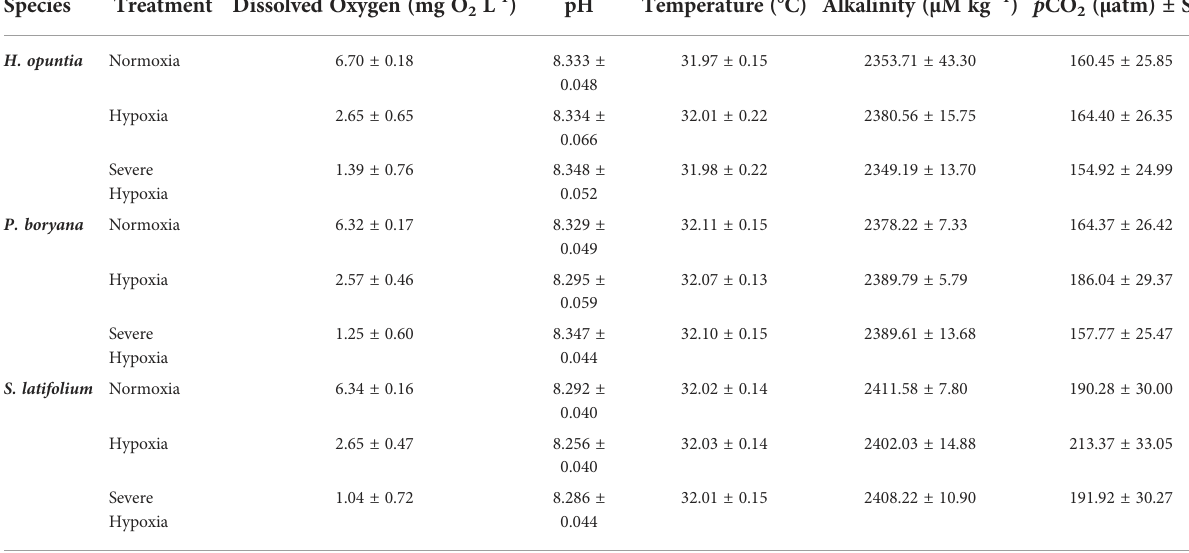
TABLE 1 Mean ± SD of environmental parameters for each tested species experiment.